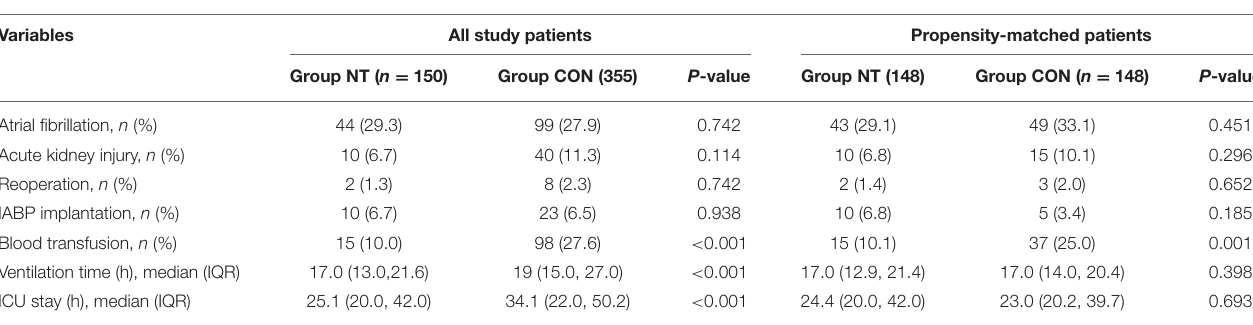
TABLE 3 | Comparison of early results in hospital. Variables